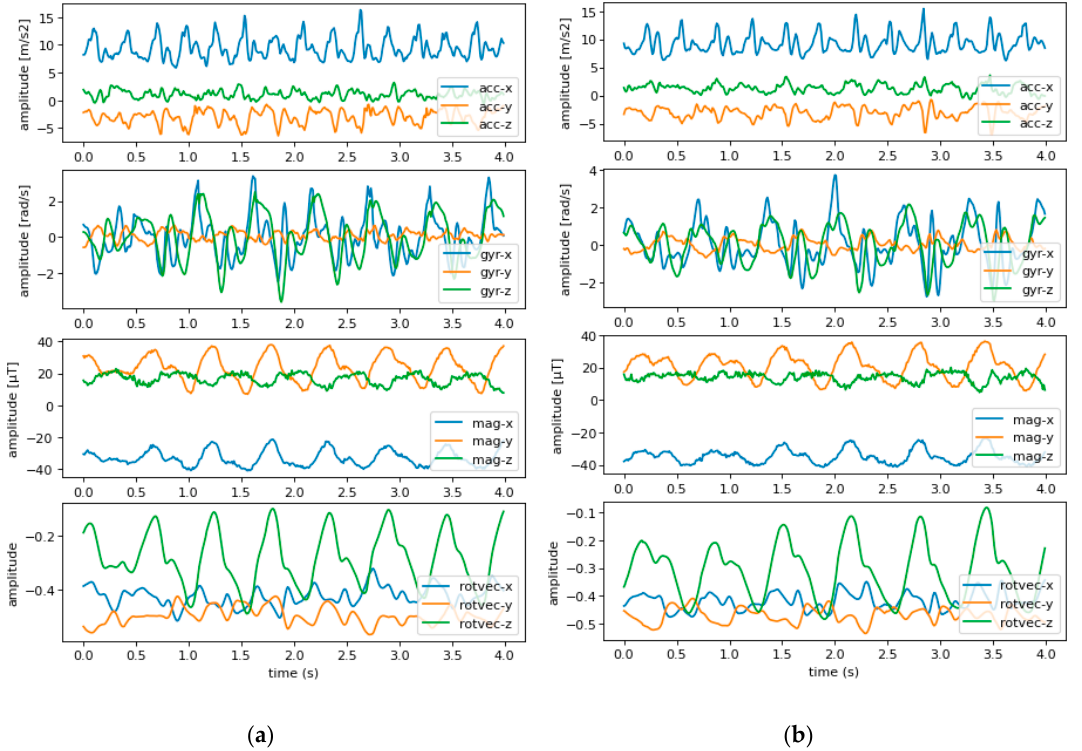
Figure 2. An example of two motion samples of 8 s from the smartwatch worn on the right wrist of one subject. ( a ) Normal walk; ( b ) abnormal walk. Acc—accelerometer, gyr—gyroscope, mag—magnetometer, rotvec—rotation